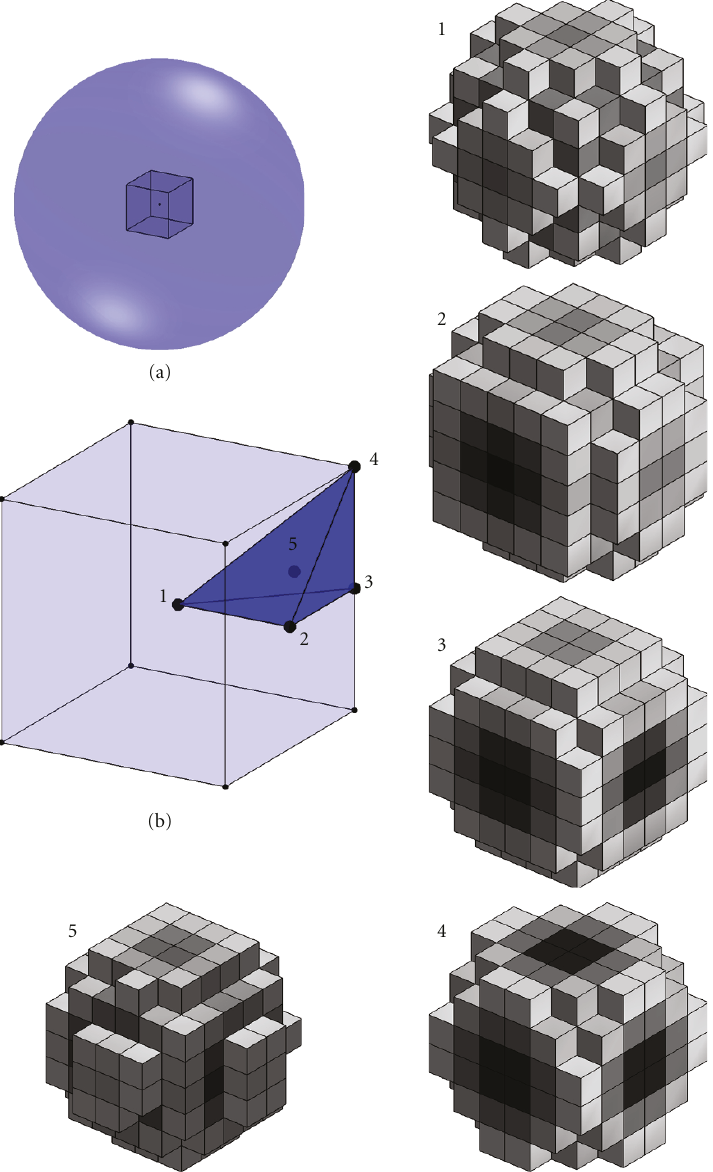
Figure 4: (a) A marker sphere showing OCV. (b) An OCV showing the tetrahedron in which the appearance of markers varies uniquely. The most symmetric appearances are 1 mid voxel, 2 mid face, 3 mid edge, and 4 voxel corner. Appearance 5 is in the middle of the tetrahedron and shows the resulting asymmetric